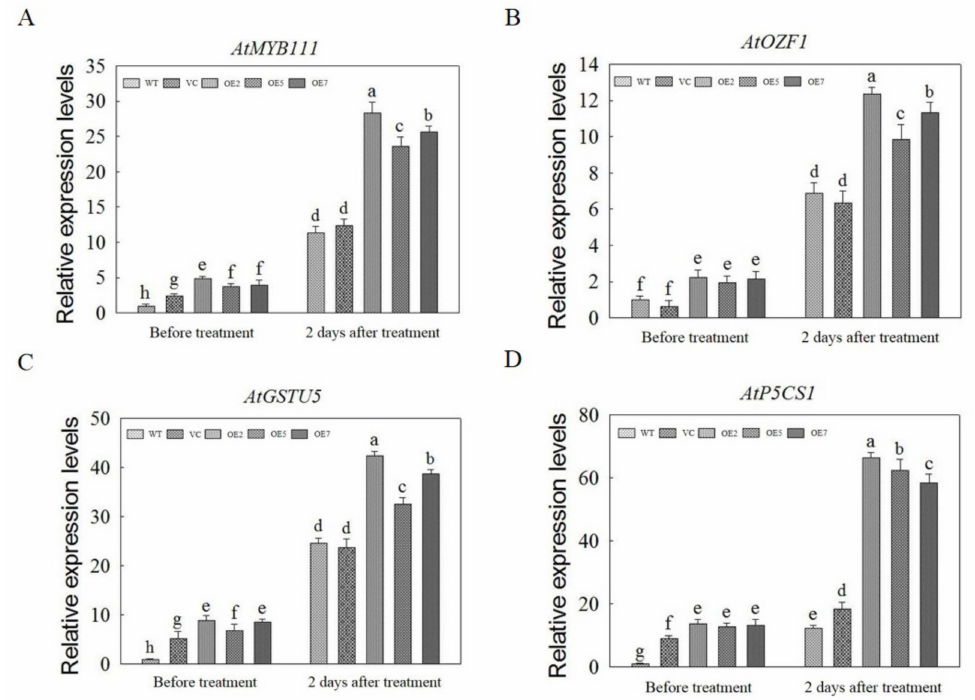
Figure 10. The relative expression levels of salt stress-related genes. ( A ) The relative expression levels of AtMYB111 . ( B ) The relative expression levels of AtOZF1. ( C ) The relative expression levels of AtGSTU5 . ( D ) The relative expression levels of AtP5CS1 . Different letters represent significant difgerences ( p <